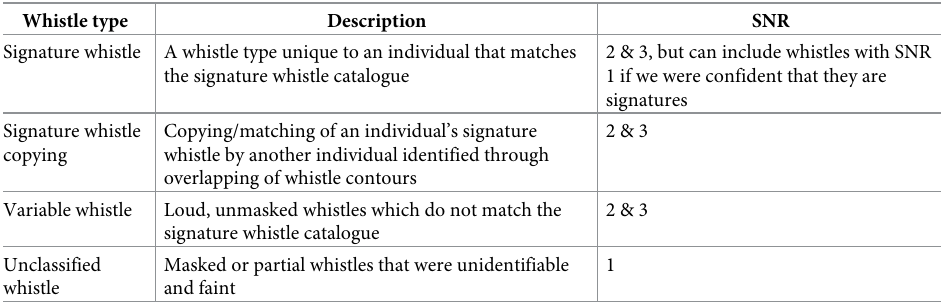
Table 2. Whistle categories included in the analyses and recording quality rating based on signal to noise